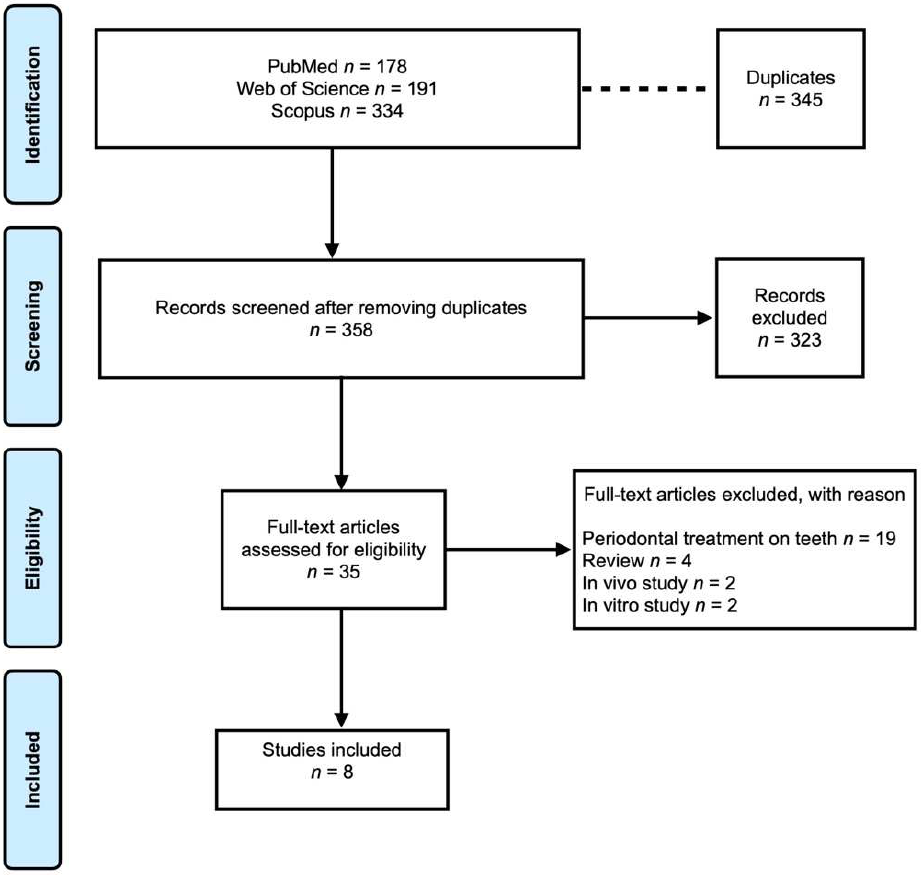
Figure 1. Prisma flowchart.